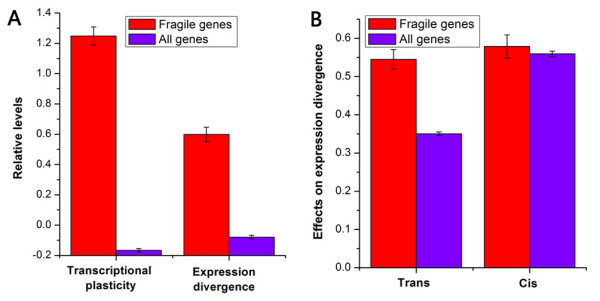
Features in gene expression that are specific for fragile genes. (A) Average values that correspond to transcriptional plasticity and expression divergence between yeast species are shown for fragile genes (red) and all genes (violet). Values in each property were normalized, such that their means are zero and standard deviations are one. (B) Average values that correspond to trans and cis effects on expression divergence are shown for fragile genes (red) and all genes (violet). Error bars were calculated by bootstrapping.